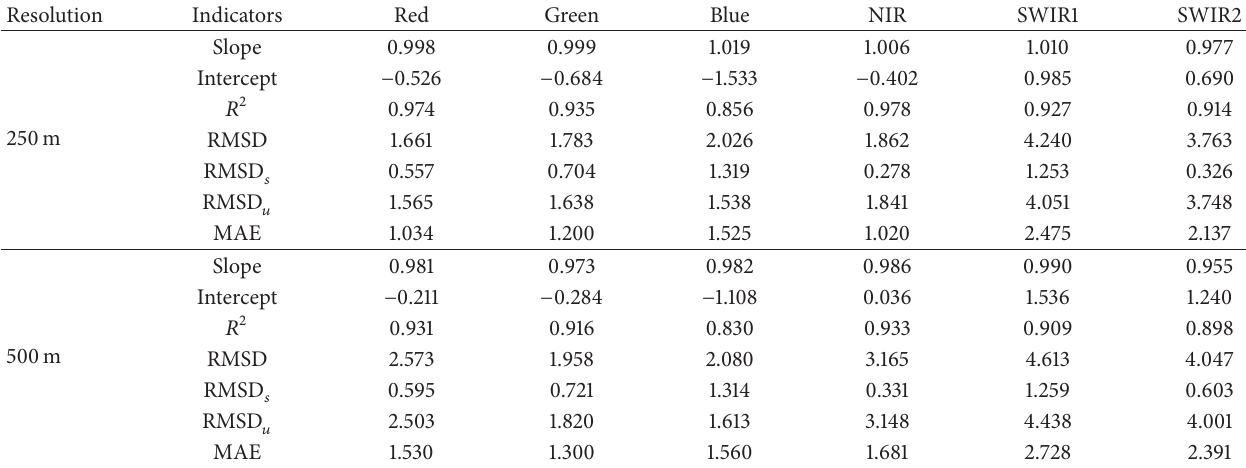
Figure 5: False color composite images (621) over Co Bangkog; October 7, 2000. (a) Shows downscaled data at 250 m spatial resolution; (b) shows original data at 500 m; (c) shows Landsat-7 ETM+ image aggregated to 250 m from 30m spatial resolution. Table 2: Summary of comparison between MODIS originaland downscaled SR estimates and coincident Landsat-7 ETM+derived SR. Values are represented as percent reflectance (%) for intercept, RMSD, RMSD 𝑠 , RMSD 𝑢 and MAE. Resolution Indicators Red Green Blue NIR SWIR1 SWIR2